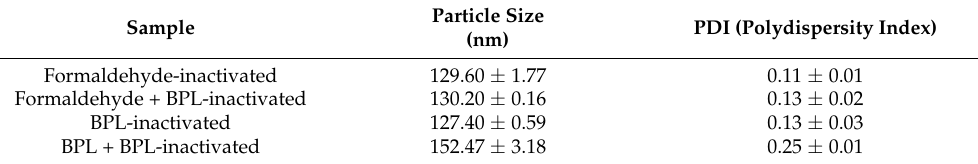
Table 1. Dynamic light scattering (DLS) results of different inactivated virus samples.